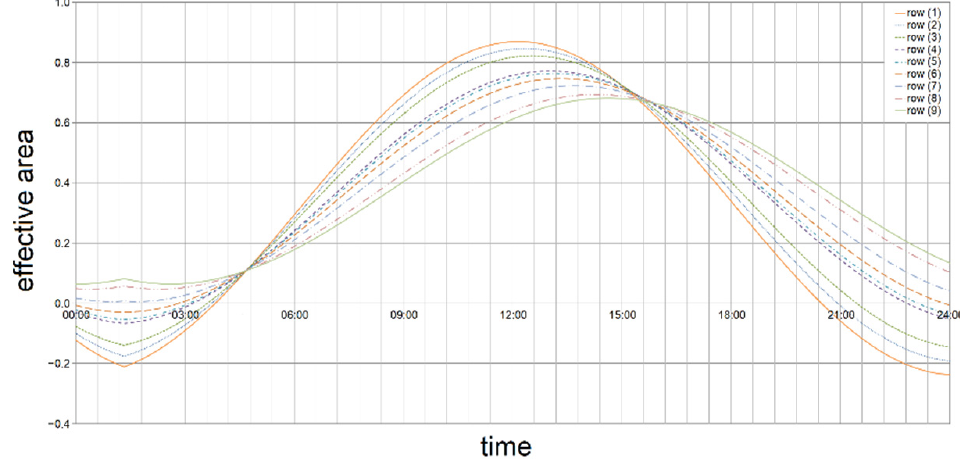
Figure 8. Effective area for ψ = 180°.